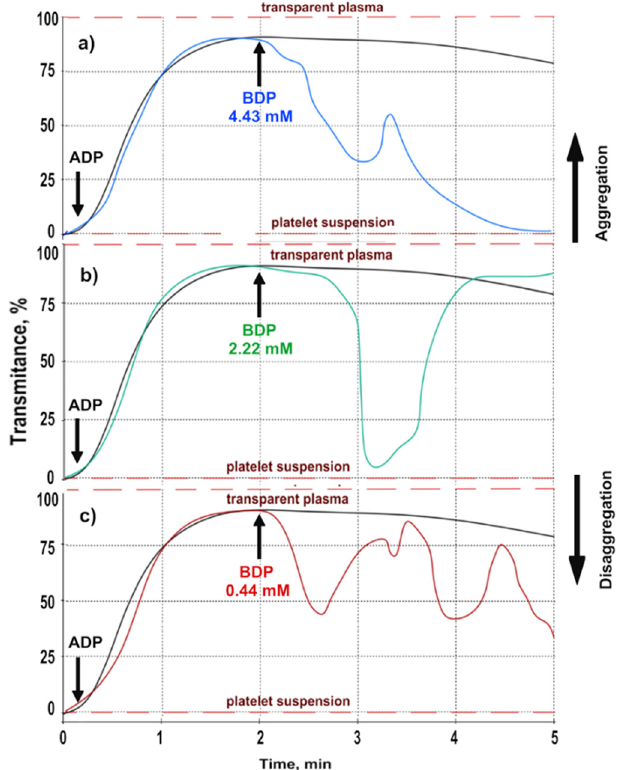
Figure 3. Dose-dependent inhibition of platelet aggregation (blood of volunteers) induced by ADP (3.75 μ M) under the action of 4.43 mM of BDP ( a ), 2.22 mM of BDP ( b ), and 0.44 mM of BDP ( c ); black line-control, ADP action (3.75 μ M). Table 3. The inhibition (%) of platelet aggregation under the action of various concentrations of